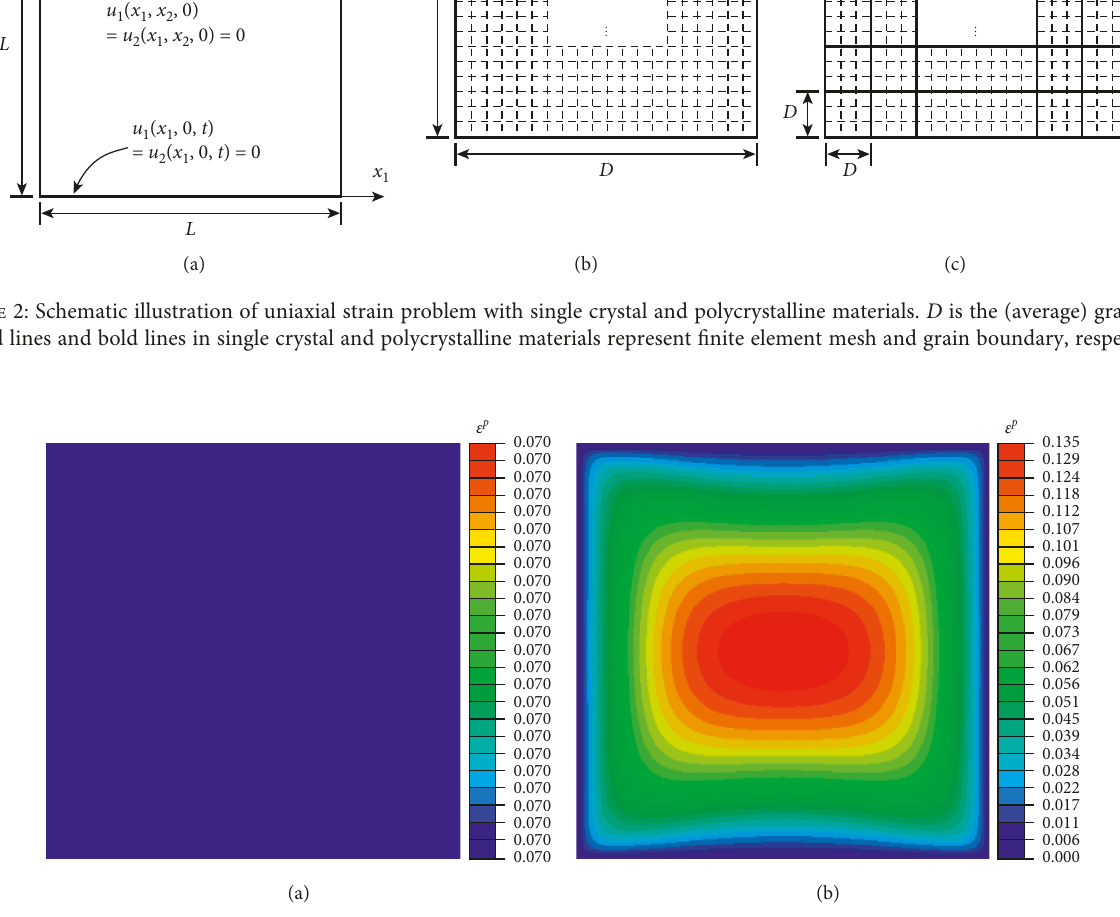
Figure 3: Distributions of the accumulated plastic strain in single crystal with (a) microscopically free boundary condition and (b) microscopically hard boundary condition [15, 18].